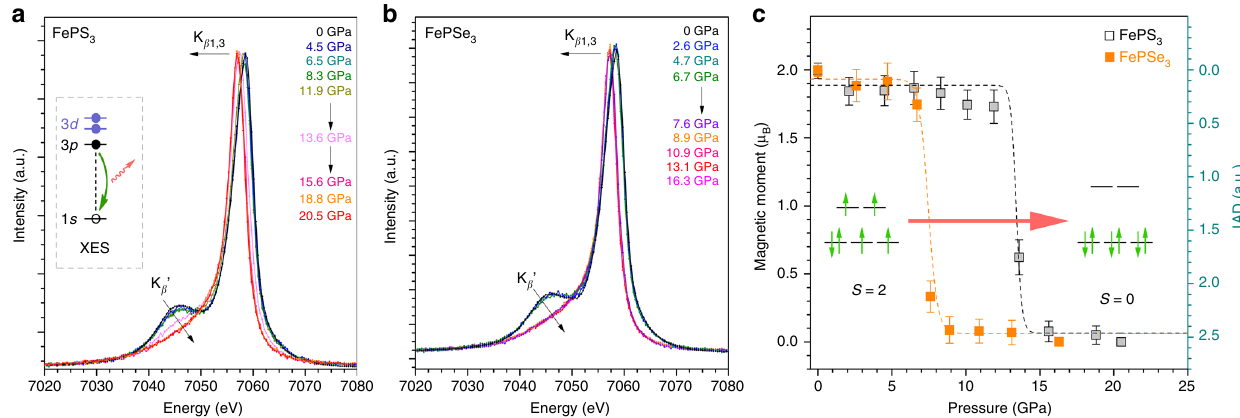
Fig. 2 XES data of FePS 3 and FePSe 3 showing the spin-crossover of Fe 2 + under compression. a , b Fe K β XES of FePS 3 and FePSe 3 as a function of applied pressure. Inset of a shows the XES process from 3 p to 1 s orbital, and the relationship with 3 d spin state. c The derived IAD values and corresponding magnetic moment numbers of FePS 3 and FePSe 3 as a function of pressure. Error bars represent ± S.D. estimated for the IAD analyses